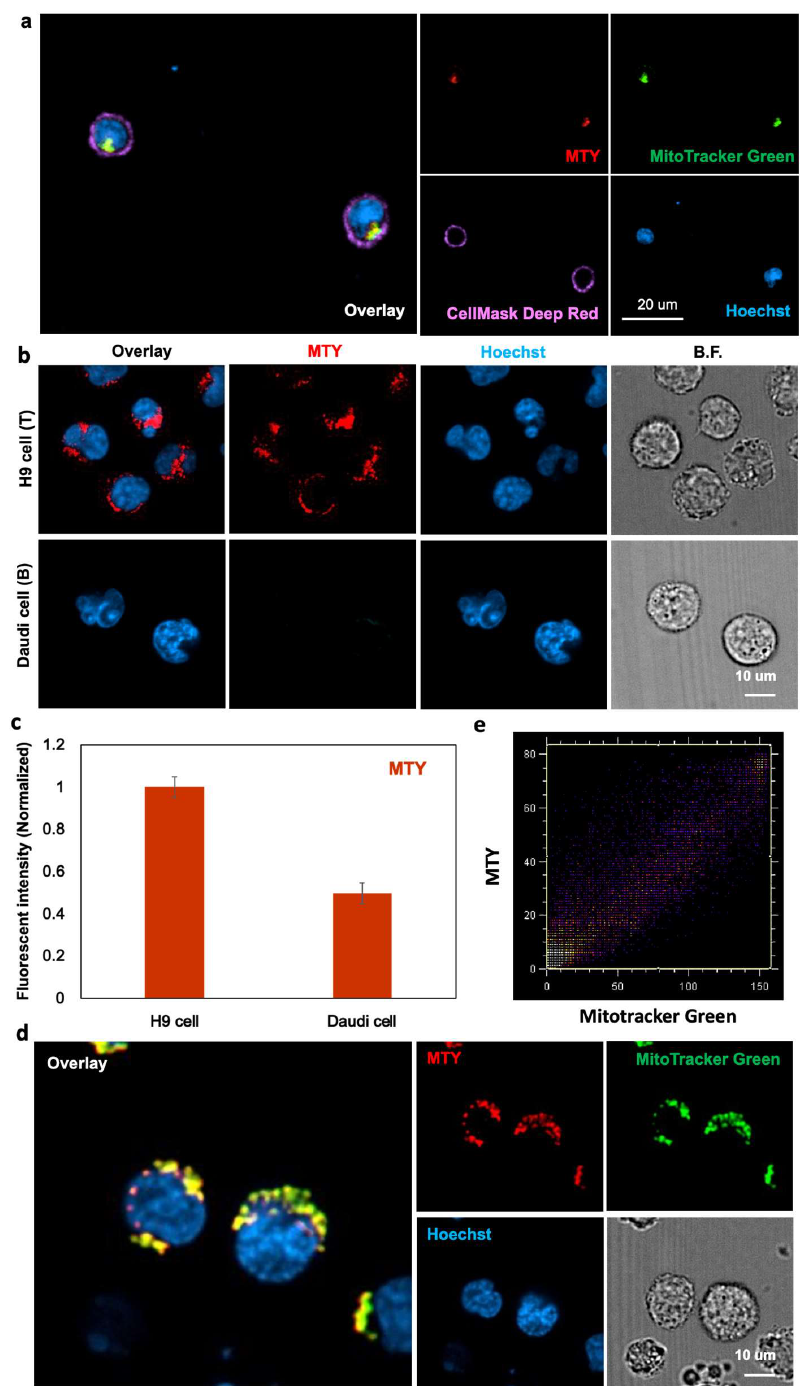
Figure 3. Localization of MTY. ( a ) Localization of MTY in human primary T cells. T cells were treated with MTY (100 nM), Mitotracker Green (200 nM), Cellmask Deep Red (5 ug/mL) and Hoechst (1 μg/mL) for 1 h, 30 min, 30 min and 10 min, respectively. ( b ) and ( c ) Selectivity of MTY in the H9 and Daudi cells. Fluorescence images ( b ) and flow cytometry ( c ) were obtained after 1 h incubation with MTY (100 nM). Fluorescent intensity evaluated by flow cytometry was normalized and repre- sented as histogram. ( d ) Localization of MTY in H9 cells. H9 cells were treated with MTY (100 nM), Mitotracker Green (200 nM) and Hoechst33342 (1 μg/mL) for 1 h, 30 min and 10 min, respectively. ( e ) Display of the colocalization areas of the red and green channels in ( d ).